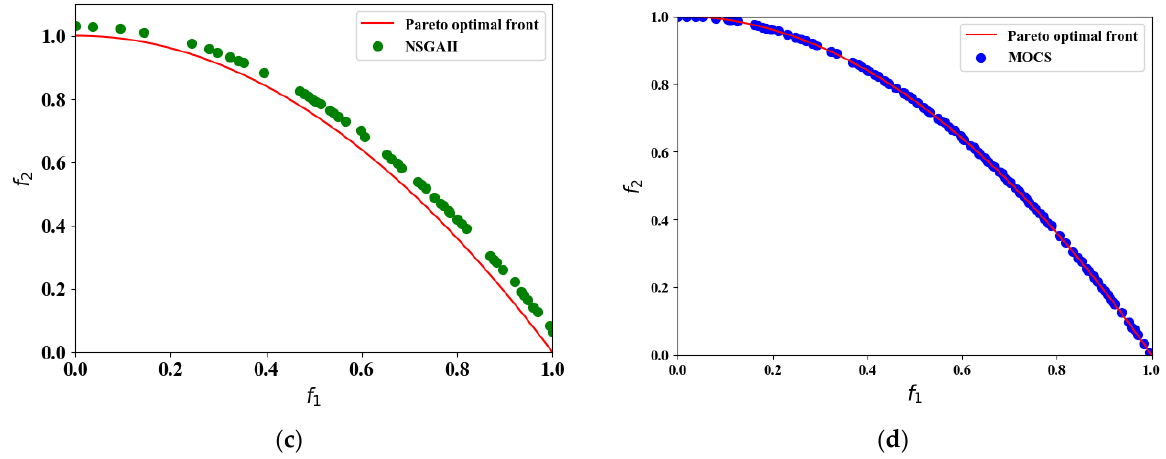
Figure 3. The convergence results of ZDT test problem over all algorithms. ( a ) IMOCS, ( b ) SPEAII, ( c ) NSGAII, and ( d ) MOCS.